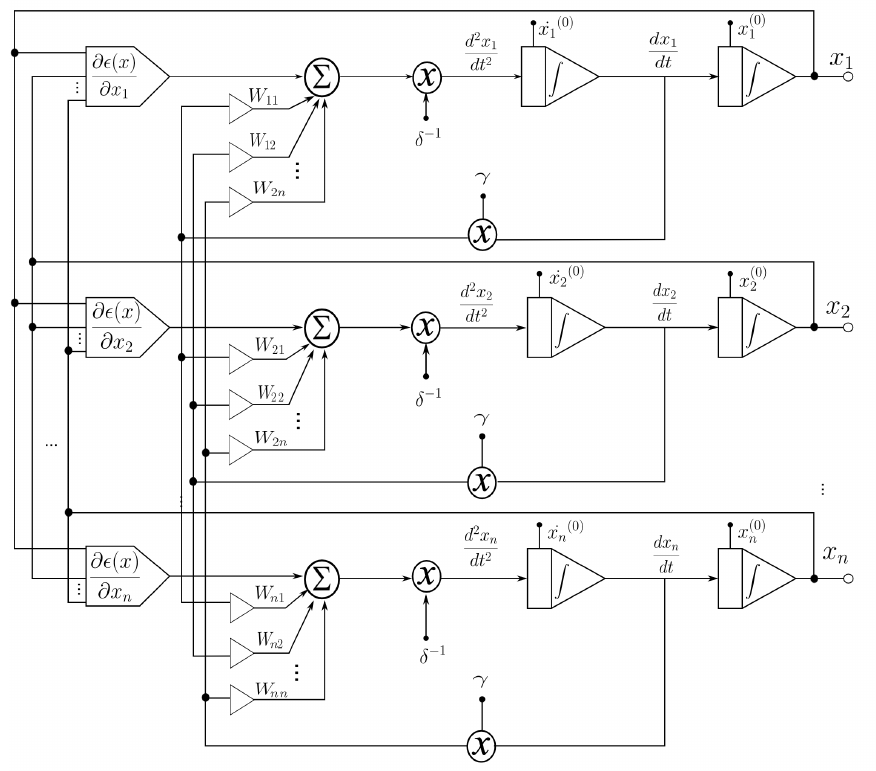
Figure 2. Block diagram for applications to